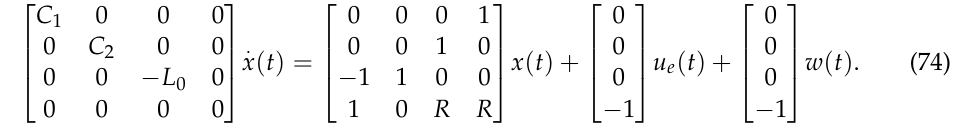
state component. ( b ) The second state component. ( c ) The third state component. ( d ) The fourth